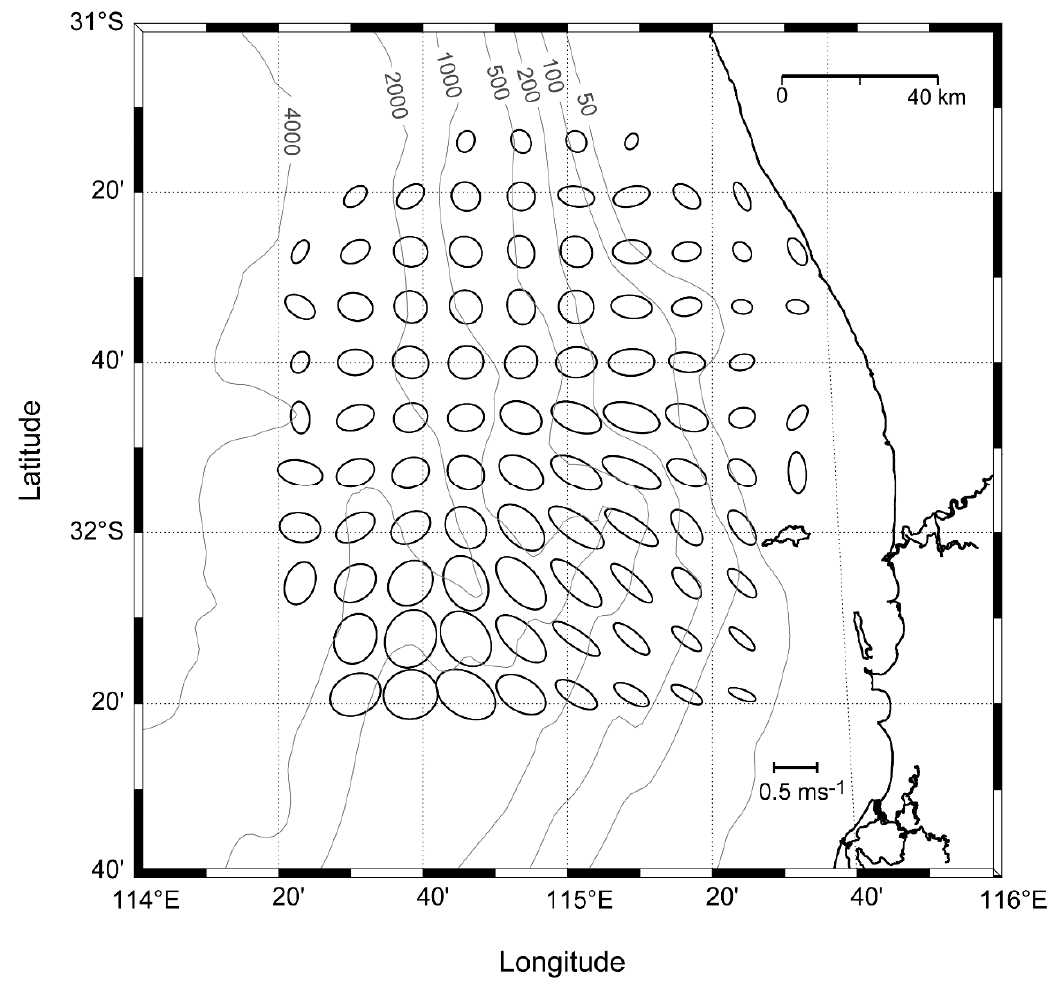
Figure 13. Diurnal surface current ellipses calculated from data collected in February 2017. For clarity, current ellipses denote every third HF Radar observation point that had at least two-thirds of temporal coverage in February 2017. All ellipses rotated anti-clockwise.